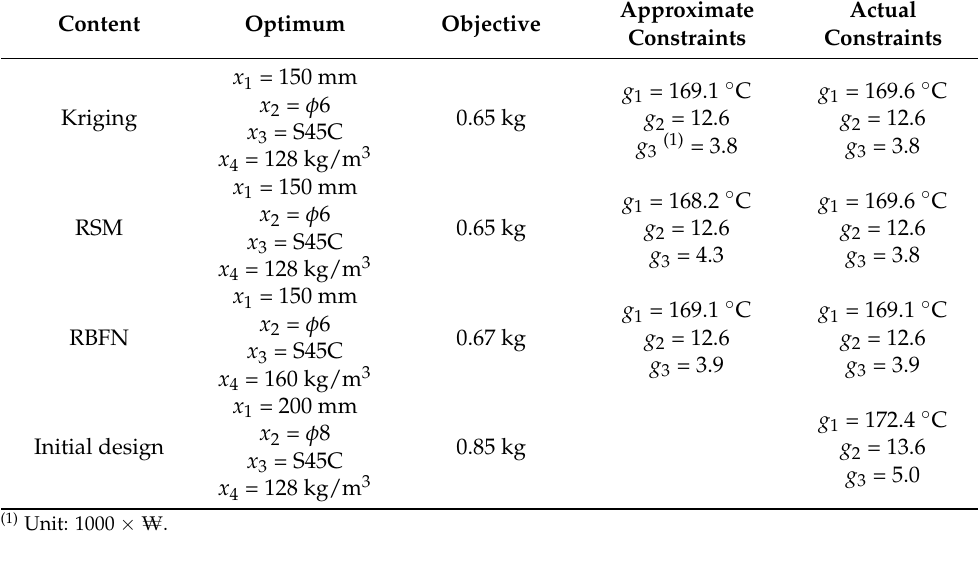
Table 7. Comparison of approximate optimization.